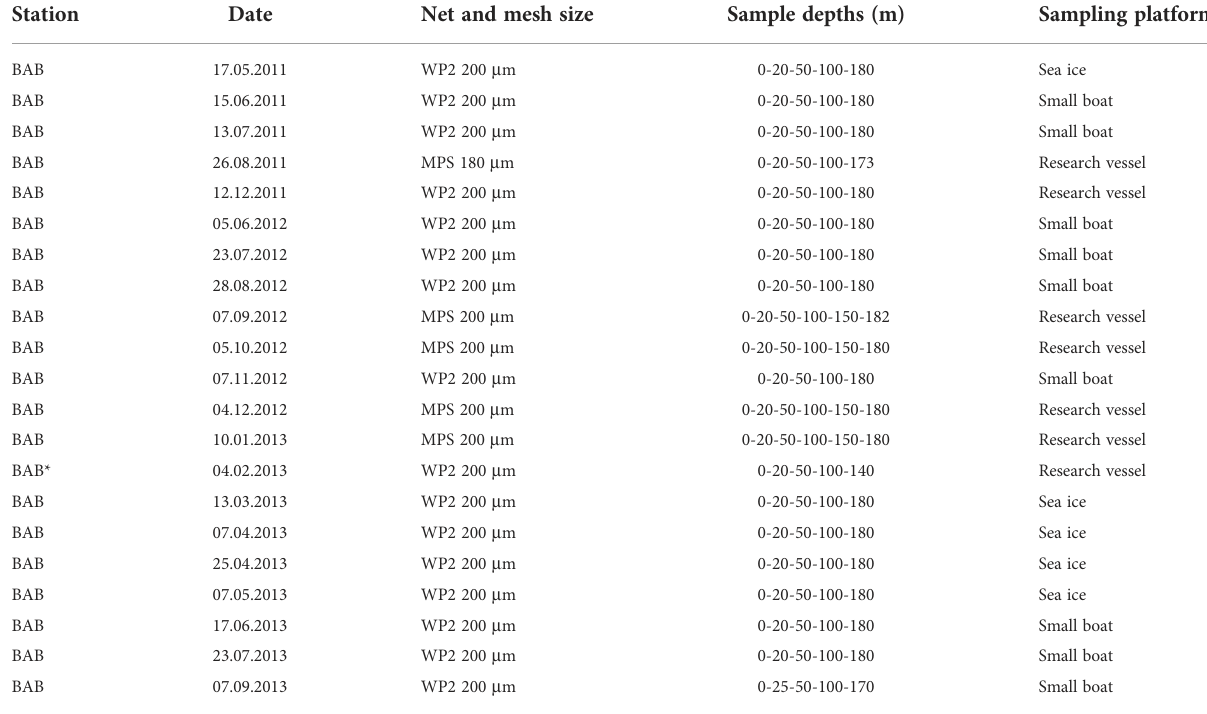
TABLE 1 Overview of sampling dates and nets used in Billefjorden at station BAB (78°40 ′ N, 16°40 ′ E; 192 m deep) from May 2011 to September 2013.